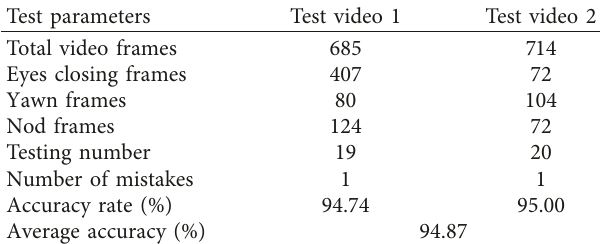
Table 2: Actual driving environment